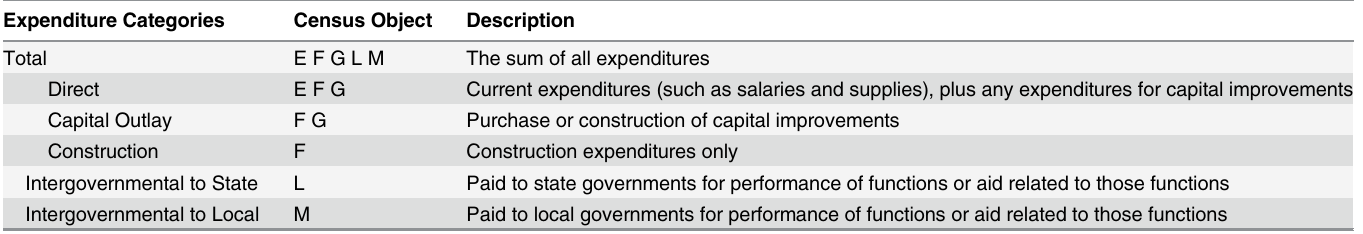
Table 7. Expenditure